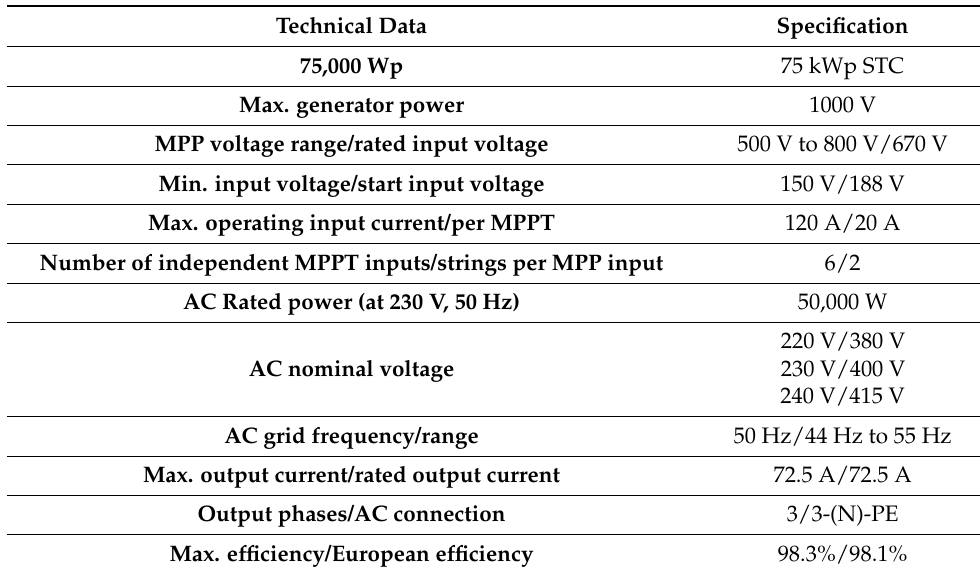
Table 3. Sunny Tripower CORE1 inverter